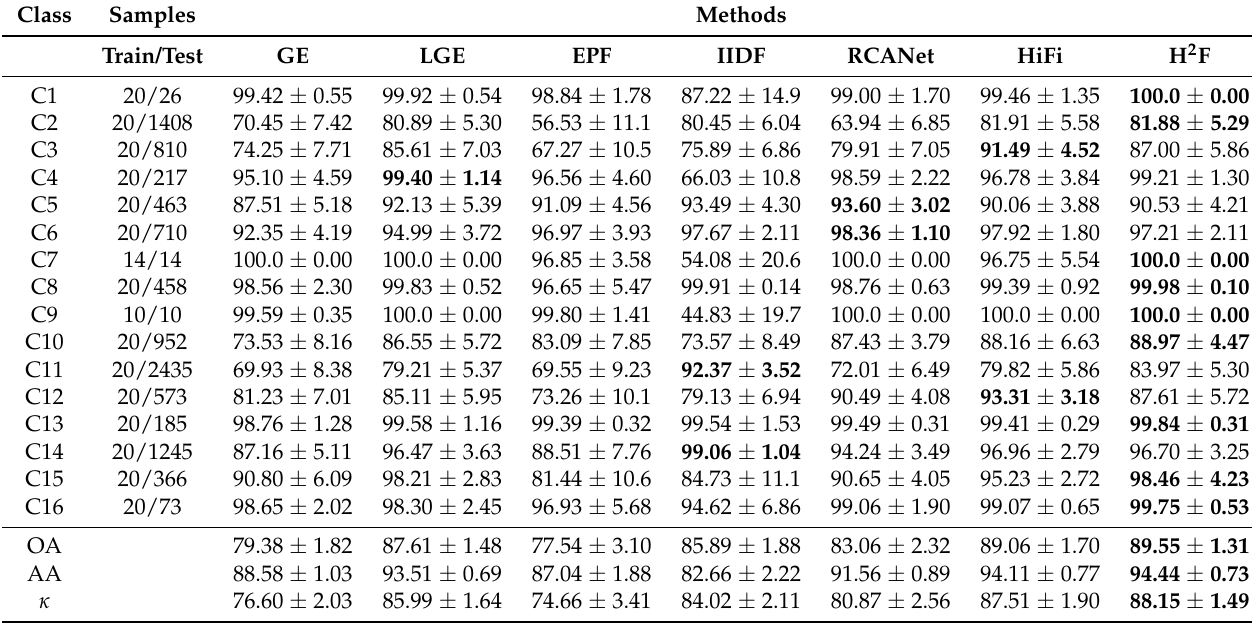
Table 1. Classification accuracies of different methods on Indian Pines data set